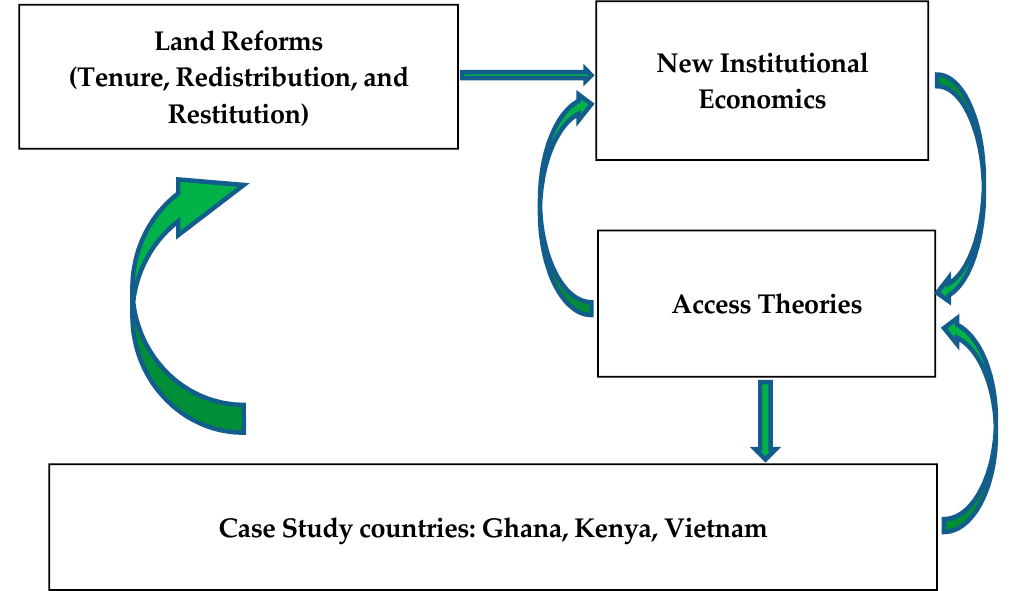
Land Reforms (Tenure, Redistribution, and